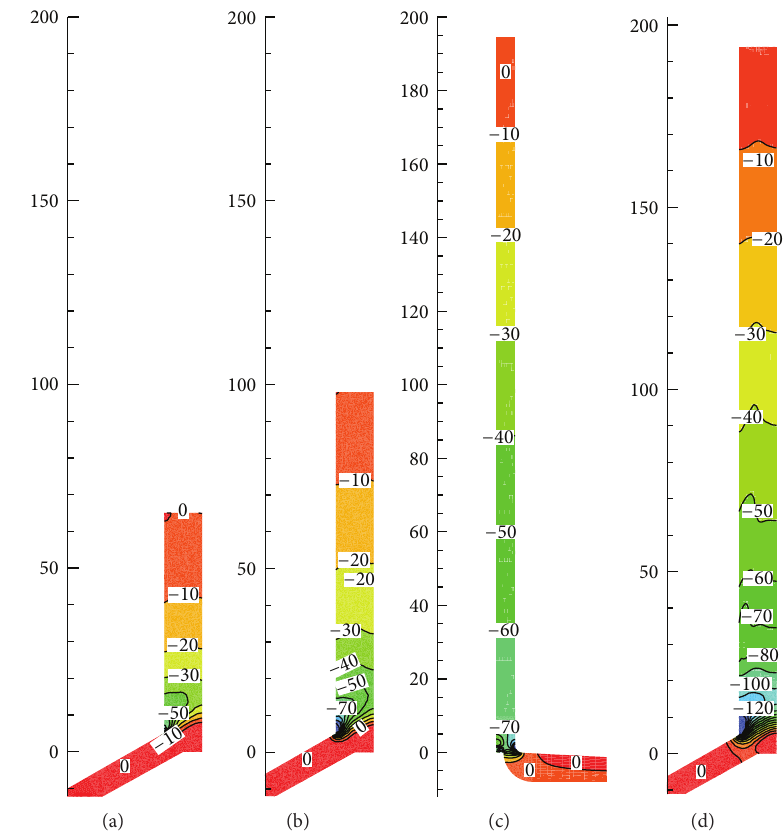
Figure 8: Inner pressure field comparison of four SCPPs with different chimney heights (pressure unit: